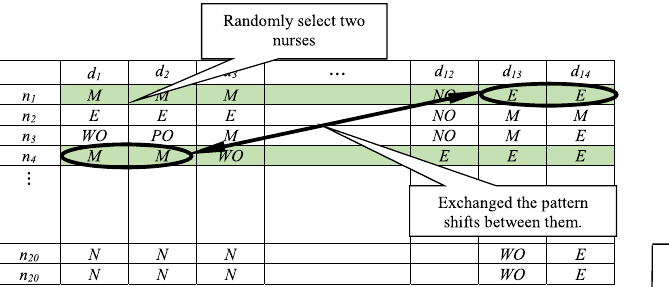
Figure 5. The possible representation of solution W ( p ) for a partial solution.